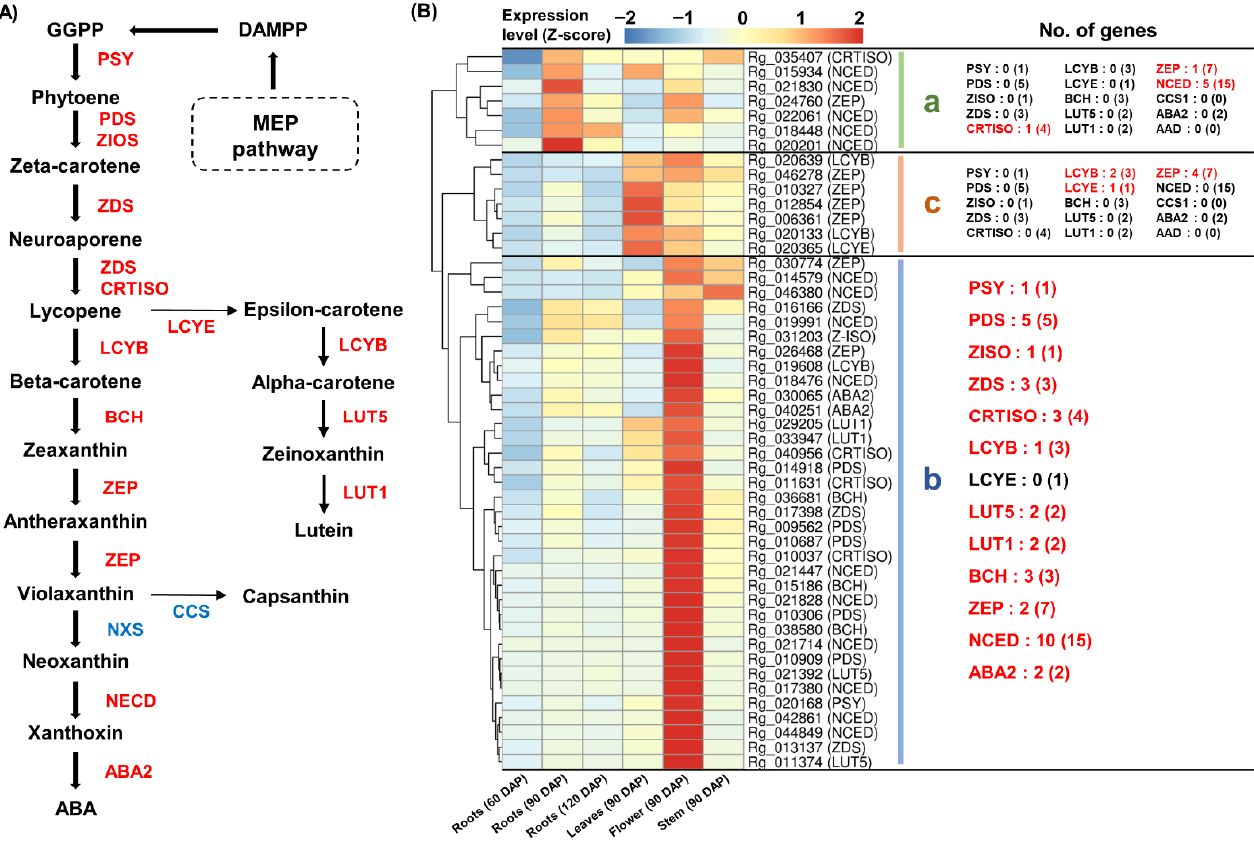
Figure 6. Expression analysis of carotenoid biosynthesis genes. ( A ) Carotenoid biosynthetic path- way in plants. Genes that were missing in this study and genes with <5 TPM values are shown in blue. ( B ) Heatmap analysis of genes involved in carotenoid biosynthesis. ( a ) Genes cluster showing a high expression in the 90 DAP roots. ( b ) Genes cluster showing a strong expression in the 90 DAP flowers. ( c ) Genes cluster showing a high expression in the 90 DAP leaves and flowers. Genes highlighted in red indicate genes assigned to each cluster and the number in parentheses is the total number of genes encoding the enzyme expressed in R. glutinosa transcriptome. TPM , transcripts per million. Genes encoding PDS, ZISO, ZDS, CRTISO, LCYB, LUT5, LUT5, BCH, ZEP, NCED, and ABA2 were co-expressed in 90 DAG flowers along with genes encoding PSY (Figure